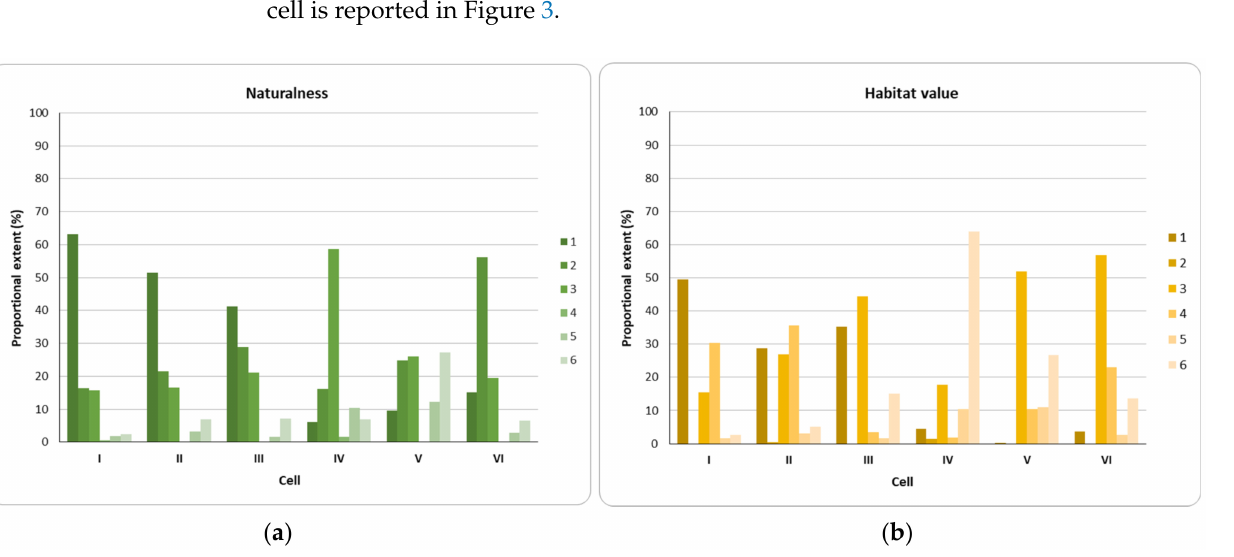
Figure 3. Proportional extent of different naturalness classes ( a ), and habitat value classes ( b ) in each grid